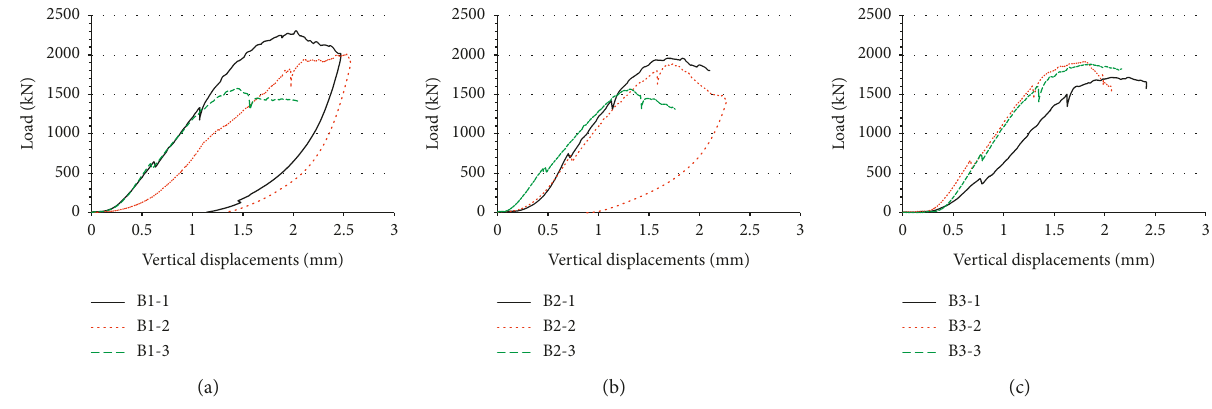
Figure 7: Load-displacement relationship for B1 (a), B2 (b), and B3